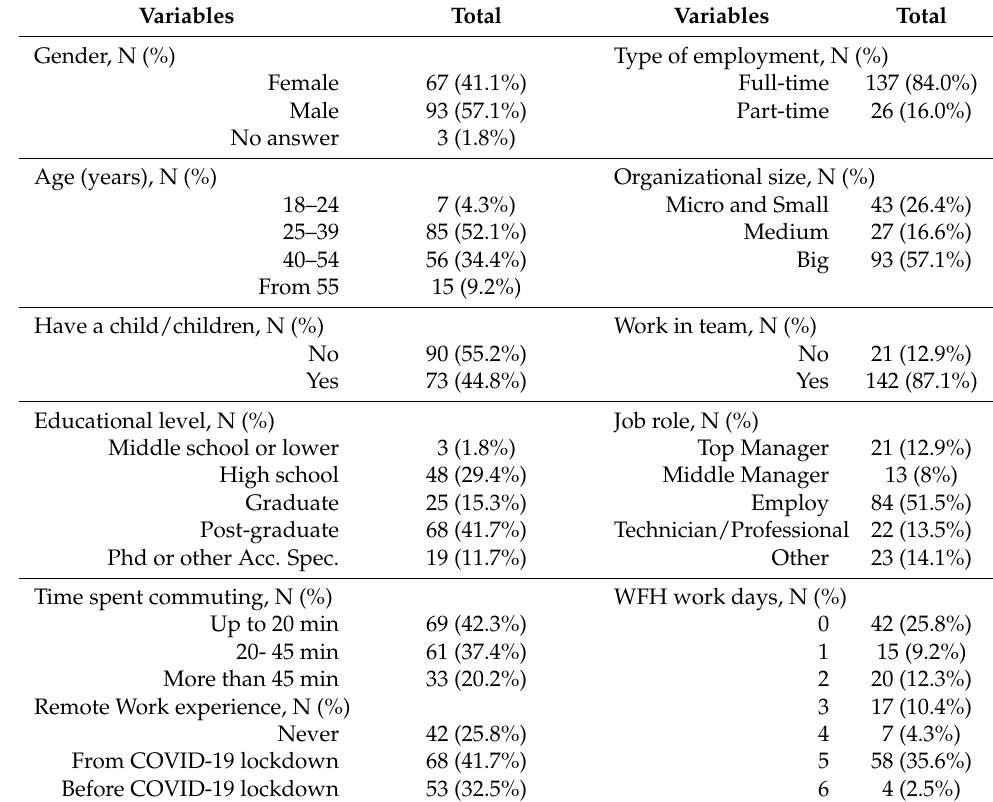
Table 1. Characteristics of the